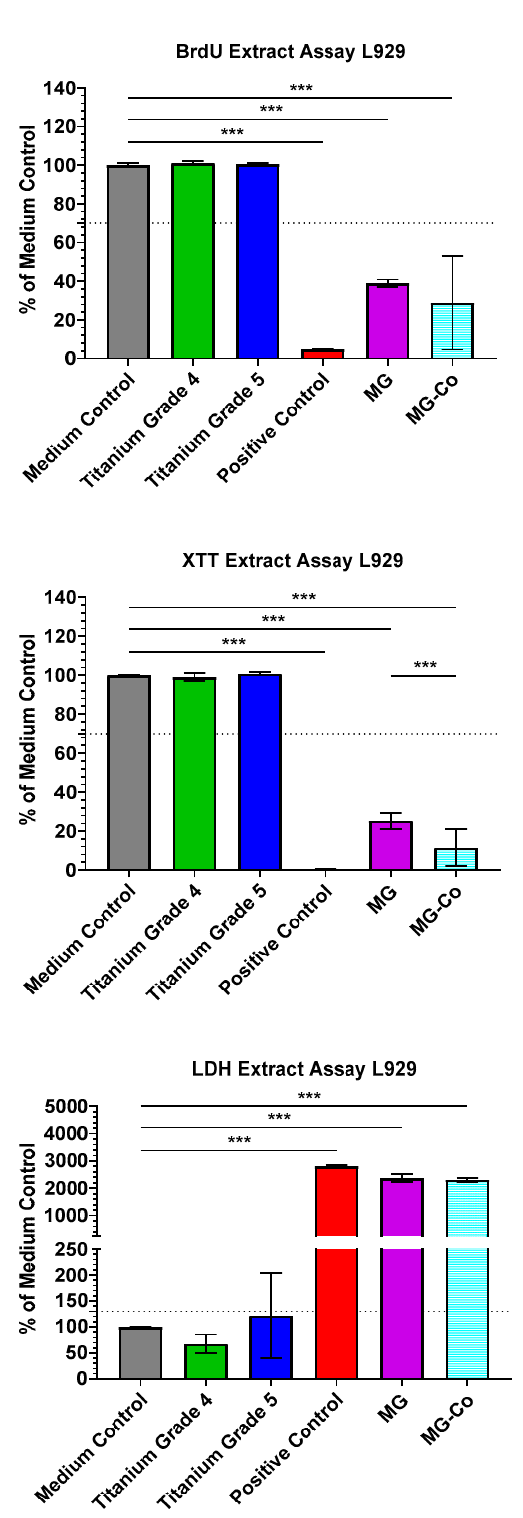
Figure 1. Cytocompatibility of both treated and untreated magnesium variants. Cytotoxicity was measured by LDH-assay; viability was measured by sodium 3,3 ′ -[1(phenylamino)carbonyl]-3,4-tetrazolium]-3is(4-methoxy-6-nitro) benzene sulfonic acid hydrate (XTT) assay, and proliferation was measured by bromodeoxyuridine (BrdU) assay. Means with error bars indicating standard deviations. The dotted line indicates thresholds that should not be exceeded (lactate dehydrogenase (LDH)) or fall below (XTT; BrdU) (*** p < 0.001).